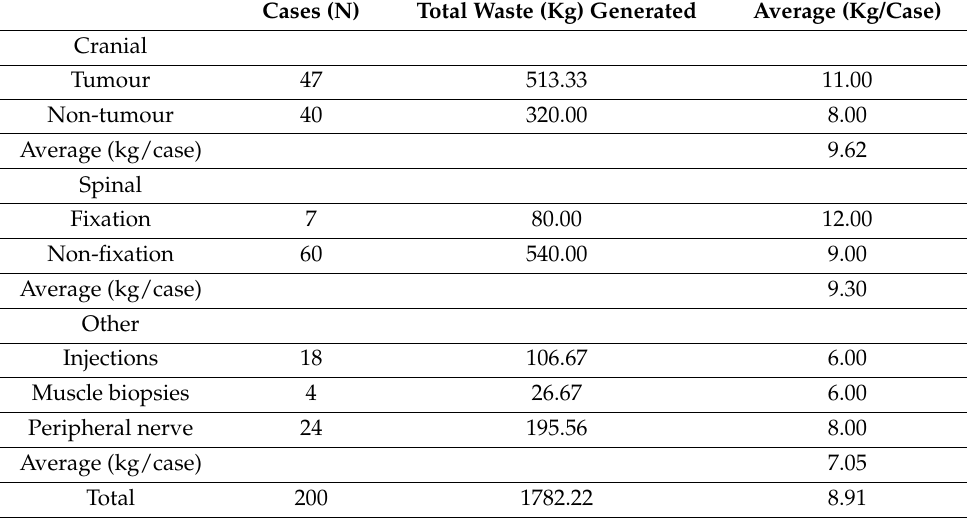
Table 1. Annual waste volume and case load by type for a neurosurgical trainee in the UK in a single unit.